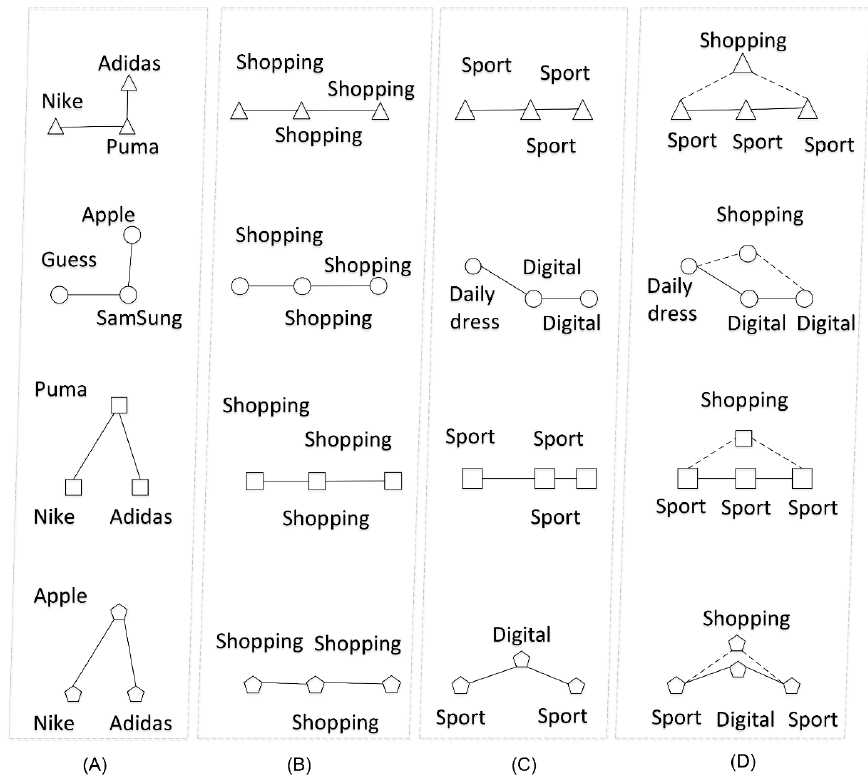
Figure 14. Multi-granularity semantic trajectory. The triangles, circles, rectangles, and pentagons denotes users 1, 2, 3, and 4, respectively: ( A ) The shapes of the indoor planar trajectories is not suitable for evaluating user similarity; ( B ) Using only the coarse-grained semantic information can’t reflect the differences visually; ( C ) Using only the fine-grained semantic hierarchy will cause the measurement of the similarity between users to fall into a local trap; ( D ) Multi-granularity semantic trajectory is consistent with the actual situation.